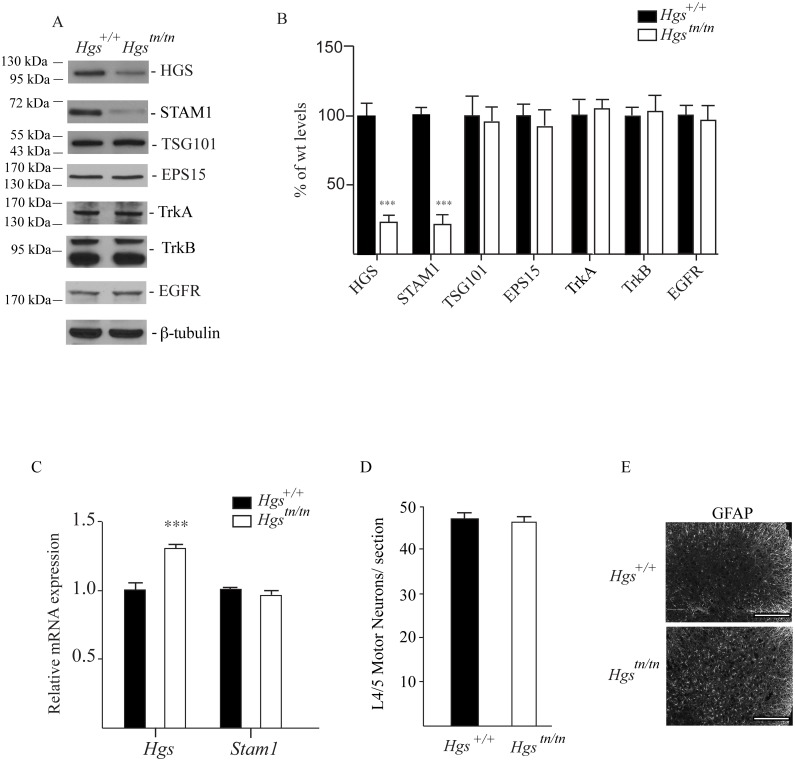
Levels of HGS-interacting proteins and putative substrates in spinal cord extracts of 4-week-old Hgs
+/+ and Hgs
tn/tn mice.(A) Representative immunoblot and (B) quantitation of the ESCRT-0 proteins HGS and STAM1, the ESCRT-I protein TSG101, the ESCRT-0 interacting proteins EPS15, and the receptor tyrosine kinases TrkB, TrkA and EGFR in the spinal cords of Hgs
+/+ and Hgs
tn/tn mice. β-tubulin was used as a loading control. (C) qPCR analysis of Hgs and Stam1 in the spinal cords of Hgs
+/+ and Hgs
tn/tn mice. Levels are expressed relative to levels found in wild type Hgs
+/+ mice. Symbols represent unpaired t-tests corrected for multiple comparisons using the Holm-Sidak method. Data are shown as mean ± SE. (D) Motor neuron counts from lumbar segments 4/5 from Hgs
+/+ and Hgs
tn/tn mice. n = 3 mice per genotype. (E) Immunostaining of Hgs
+/+ and Hgs
tn/tn L4/5 segments with GFAP. Scale bar, 100 μm. Data are shown as mean ± SE. n > 3 mice per genotype. ***p<0.001.